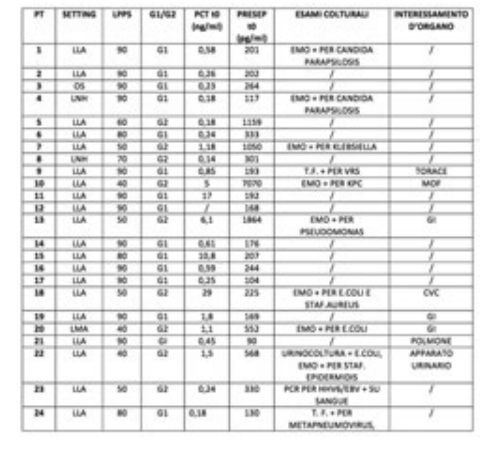
Tabella 1. PT: paziente, Lpps: lansky play performance score index for pediatric functional status, Pct: procalcitonina,